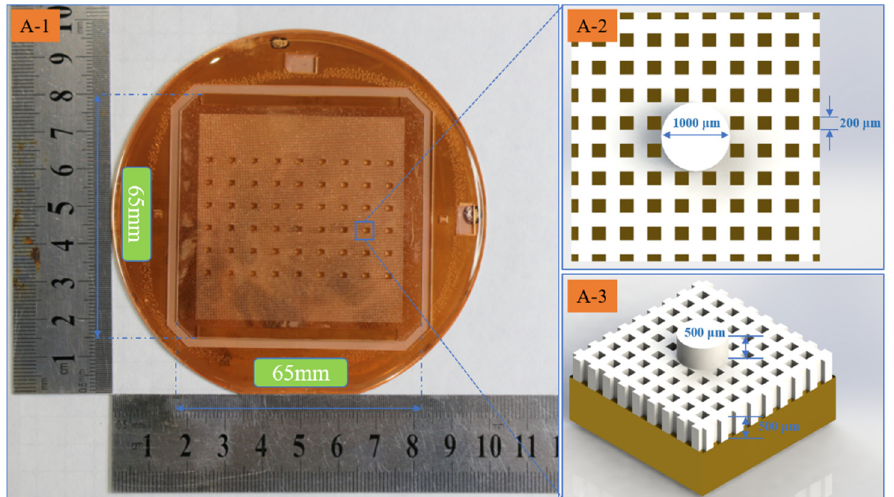
Figure 11. Structure diagram of multi-layer SU-8 microstructure formed in large area. ( A-1 ) Surface topography of overall structure, ( A-2 ) surface topography, and ( A-3 ) 3D structure of unite.